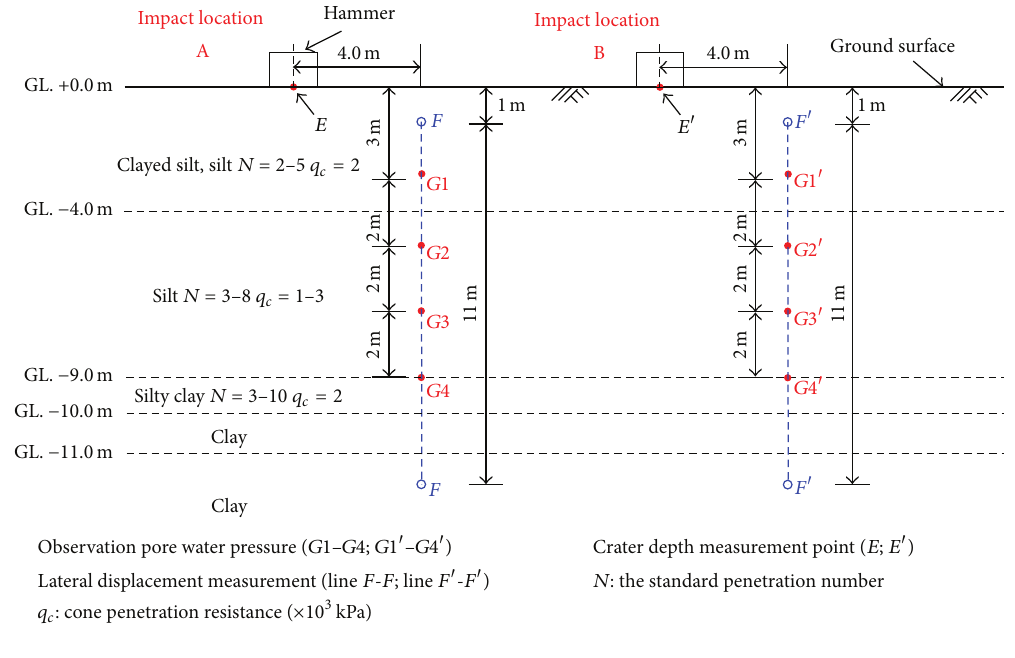
Figure 6: The geology profile and plan layout of monitoring system.